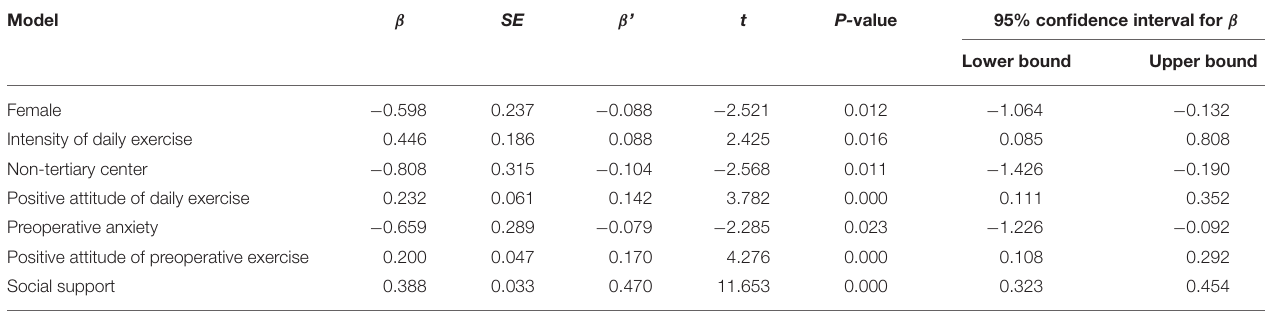
TABLE 2 | Multivariate liner regression analysis for perioperative exercise intention ( N =